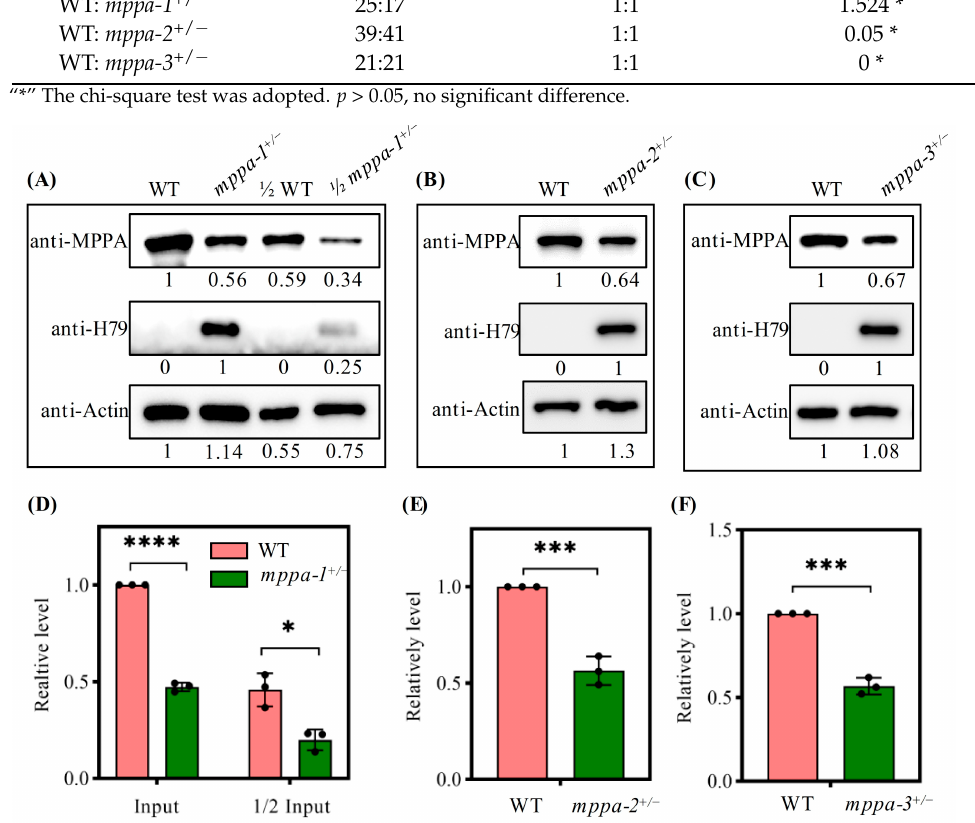
Figure 4. Semi-quantitative analysis of MPPA protein levels in the anther of WT and heterozygotes. ( A – C ) Total protein samples were prepared from the anther of the wild-type rice and heterozygous mutants during the heading stage. Loading quantity of lanes 3 and 4 were half of lanes 1 and 2 in ( A ). Three biological repeats were performed for each mutant line. ( D – F ) Quantification of the MPPA abundance in pollens of the wild-type rice and heterozygous mutants, data present mean ± SD from three independent biological repeats, Student t -test was applied, * p <0.05, *** p < 0.001, **** p < 0.0001. Actin was used as a loading control, H79 indicates the toxic protein, and the numbers calculated by Image J indicated the gray value of immunoblotting. Western blotting was performed with anti-MPPA and anti-H79 at a dilution of 1:1000, and anti-Actin at 1:5000. Table 1. mppa +/ − T 3 Segregation.